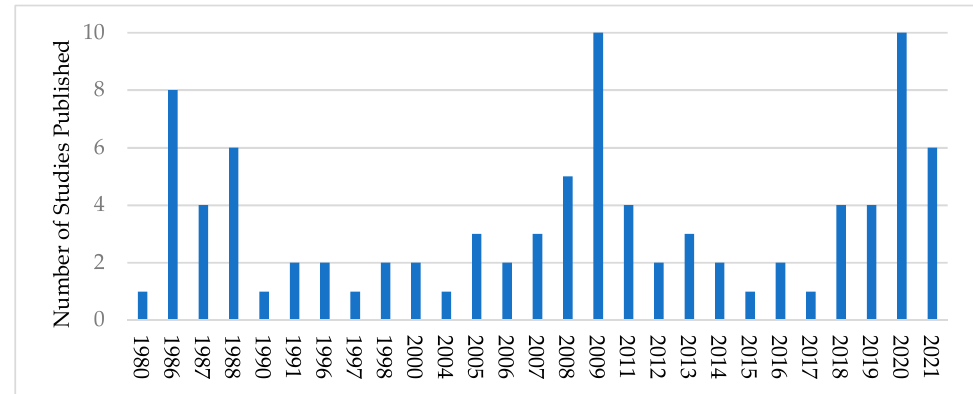
Figure 3. Number of farmer mental health intervention studies from 1980 to August 2021.